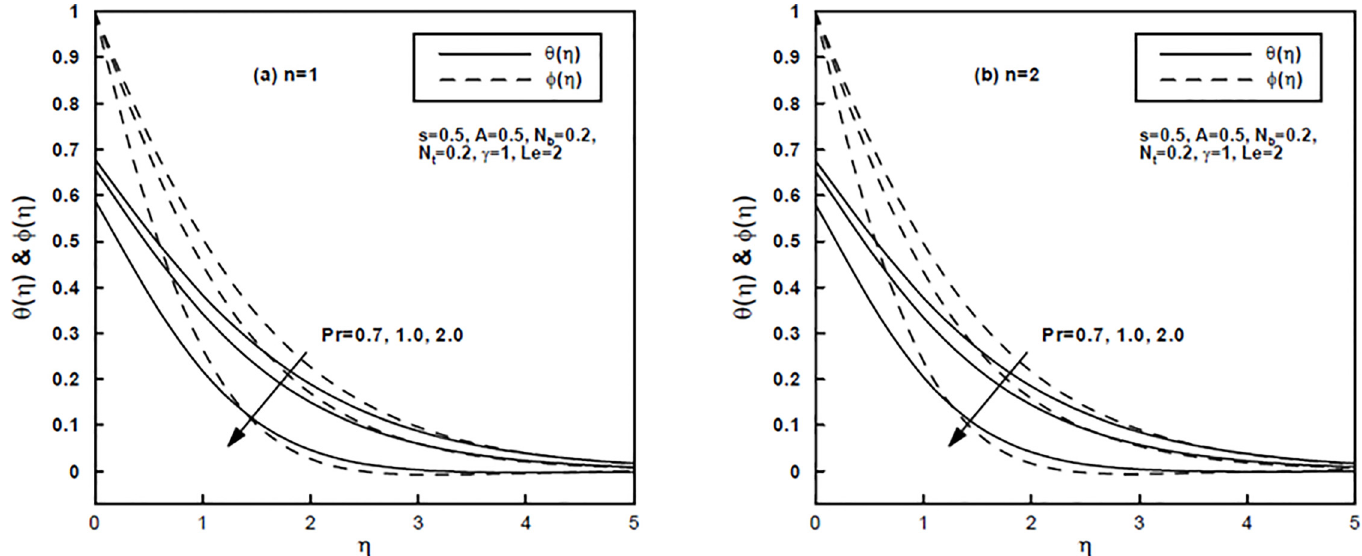
Fig 3. (a,b), The temperature and concentration profiles for different values of the generalized Prandtl number Pr.